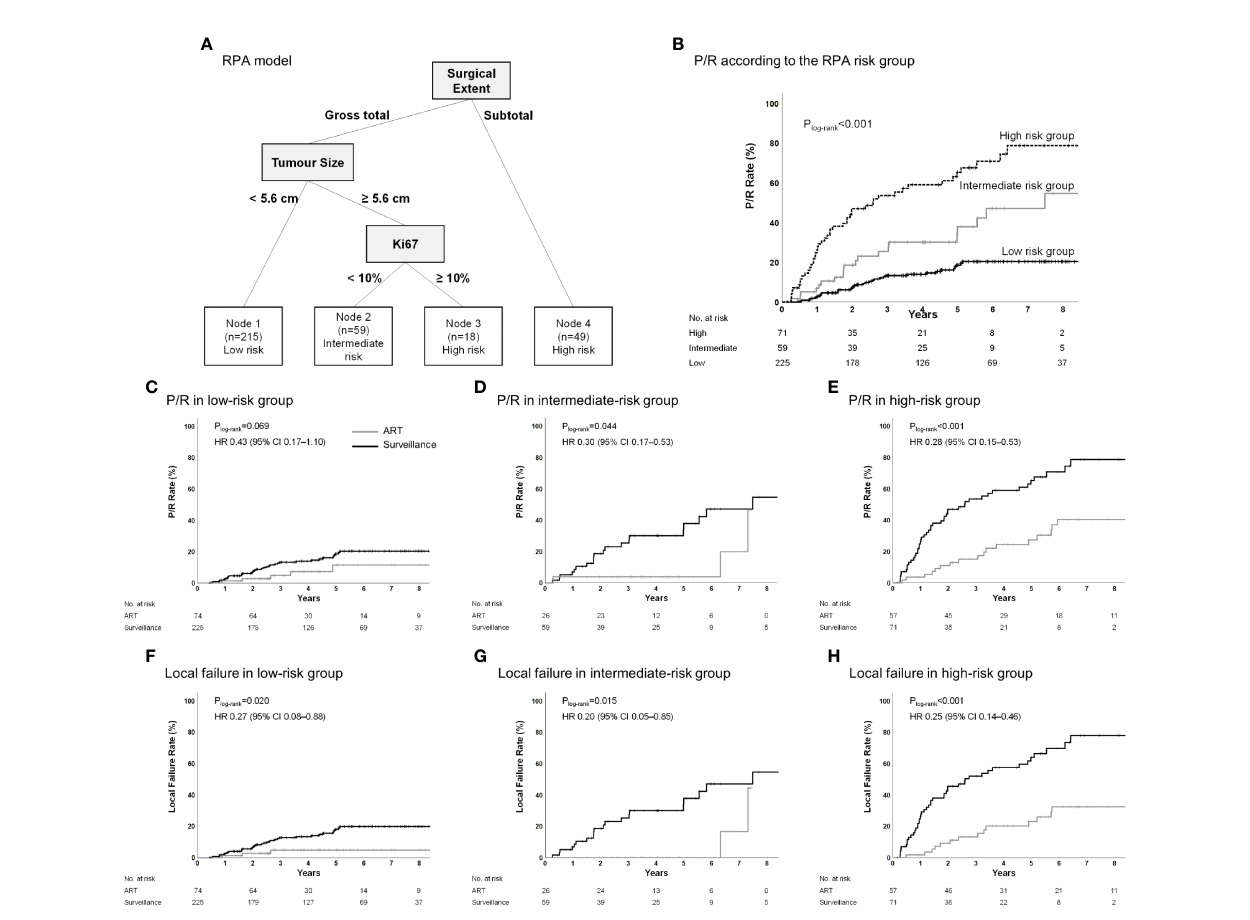
FIGURE 4 | (A) Classi fi cation of the surveillance group into risk-of-P/R categories and (B) Kaplan – Meier estimates of P/R according to these categories. (C – H) P/R and local failure in the low-risk group, intermediate-risk group, and high-risk group according to adjuvant treatment in the entire cohort. Recursive-partitioning analysis was used to identify prognostic factors with the most in fl uential predictive signi fi cance in a proportional-hazards model of P/R and to classify patients into categories of low-, intermediate-, or high-risk of P/R. ART, adjuvant radiotherapy; P/R,